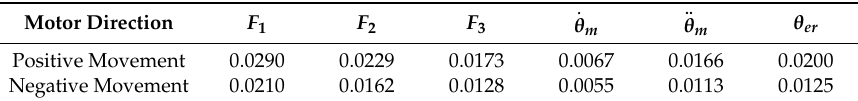
Table 1. Mutual information of features.